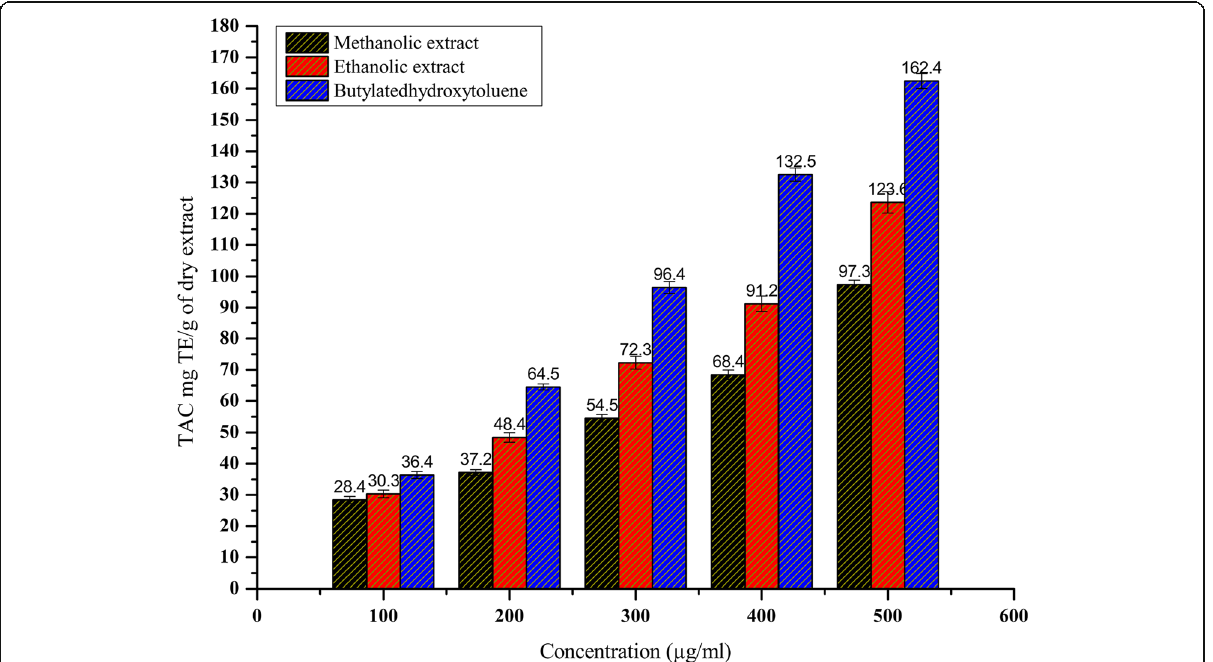
Fig. 3 Determination of total antioxidant capacity of methanolic and ethanolic extracts of C. zeylanica leaves. The results were expressed as mean ± standard